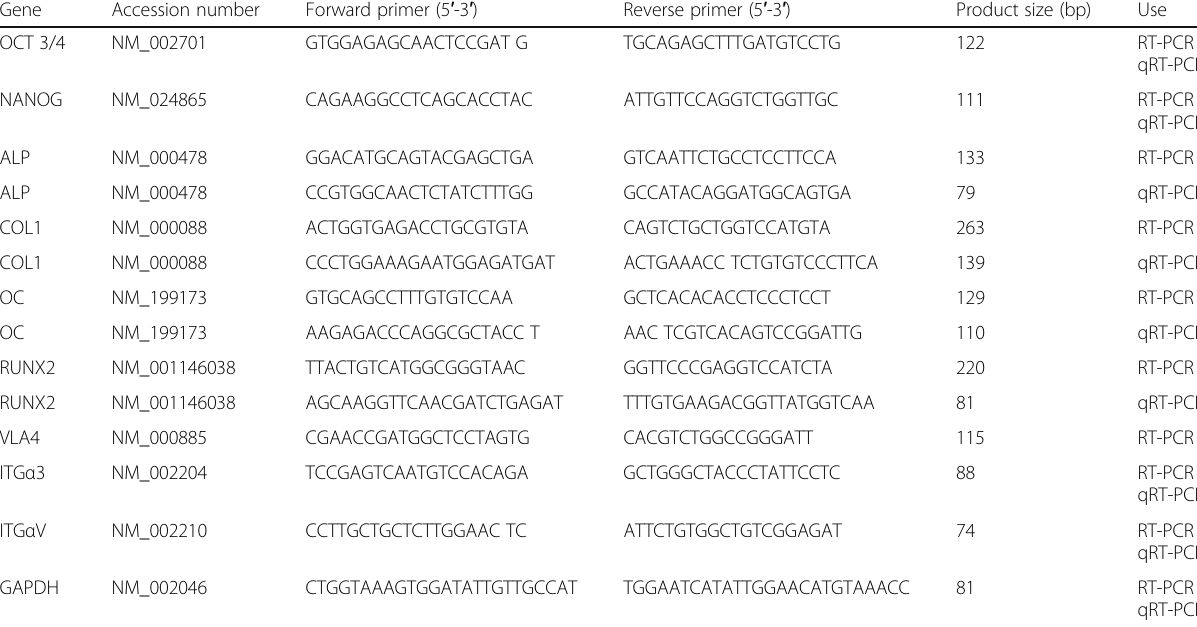
Table 1 Primer pairs used to assess osteoblast differentiation in the RT-PCR and qRT-PCR amplification